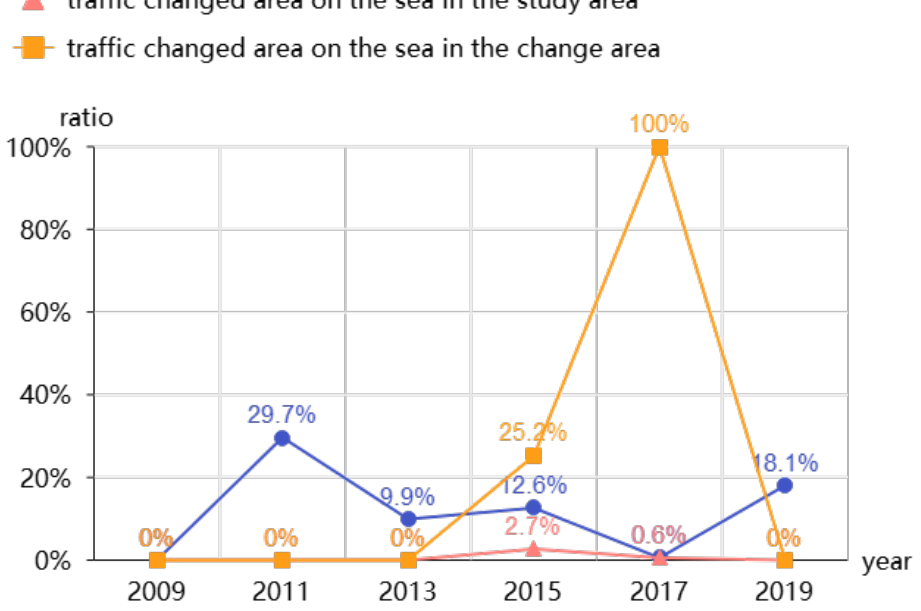
Figure 10. The analysis of change detection of the Zhuhai-Macao port.